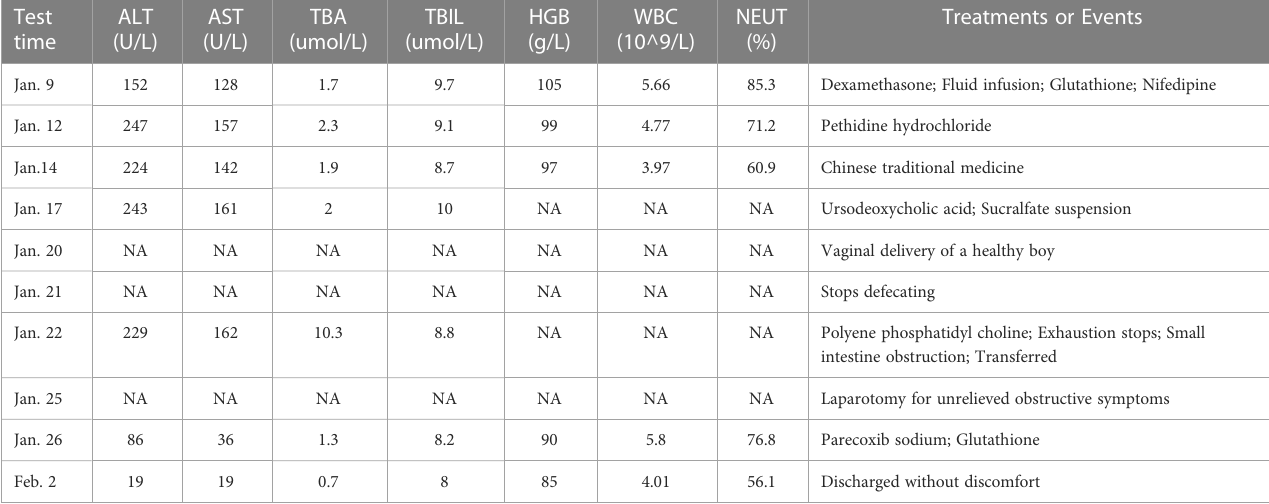
TABLE 1 Timeline of test results and the treatment